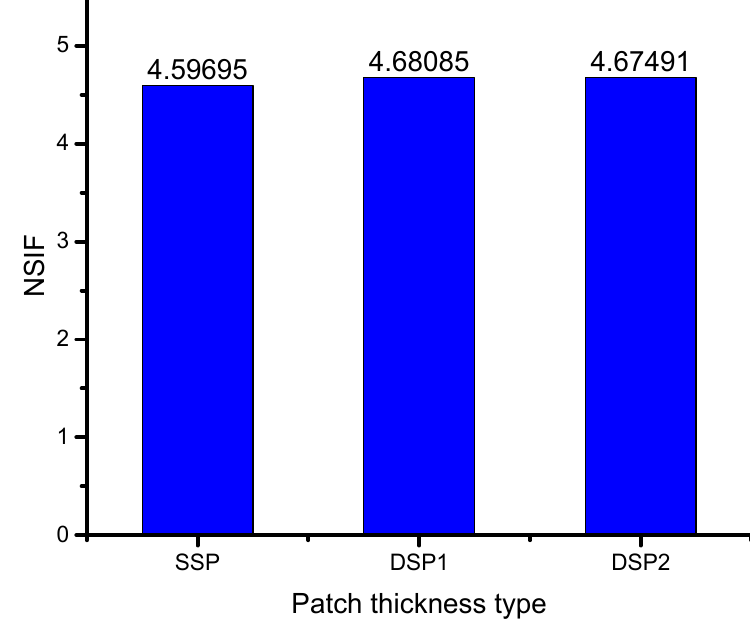
Figure 4. Effect of patch thickness type.